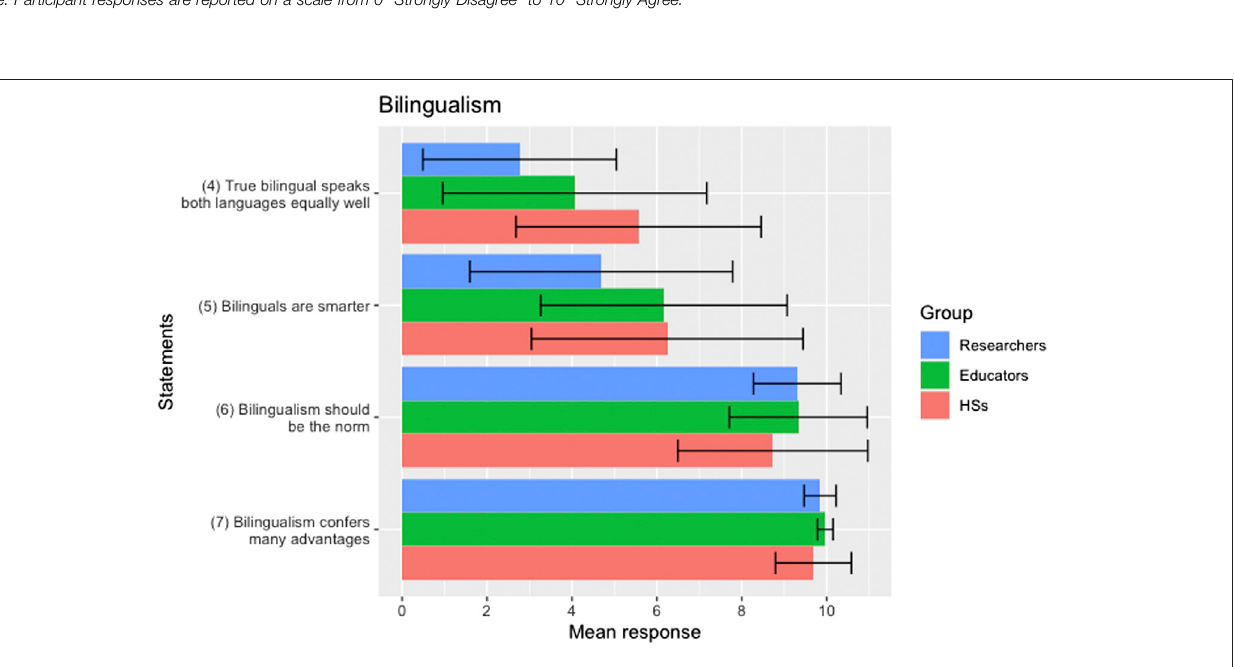
Frontiers in Education |